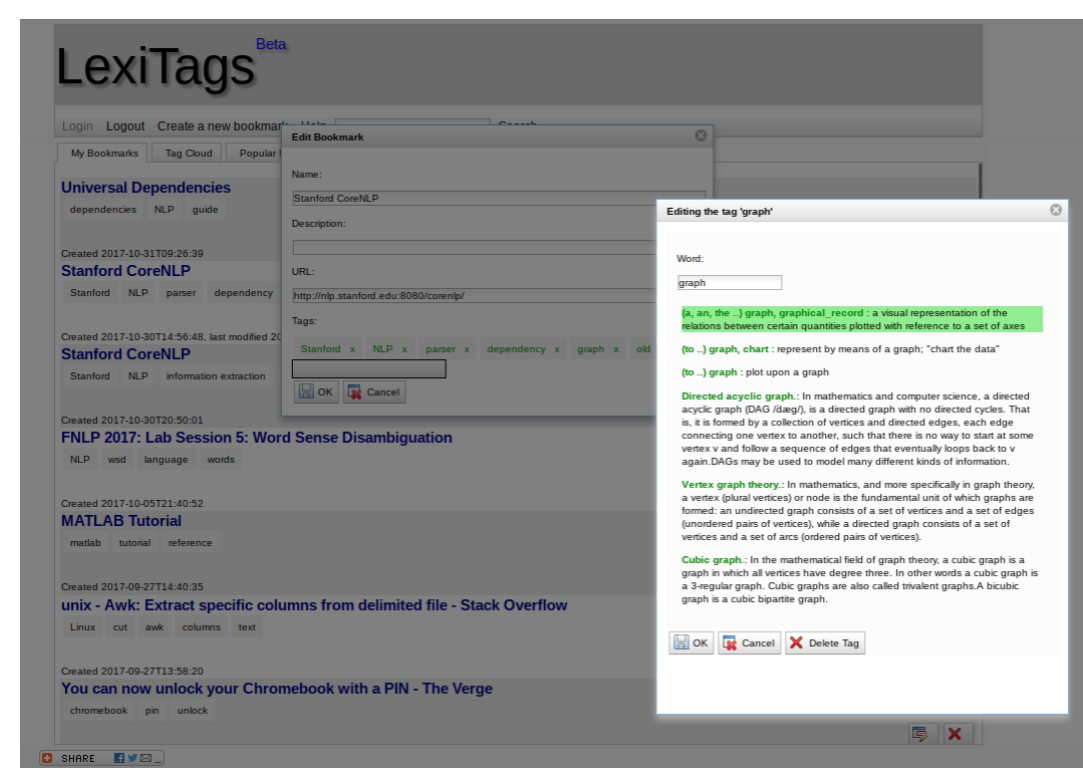
Figure 3. The LexiTags bookmarking interface. The bookmarks and editing interface are greyed out, while the disambiguation screen is visible. Words are disambiguated with WordNet synsets or DBPedia